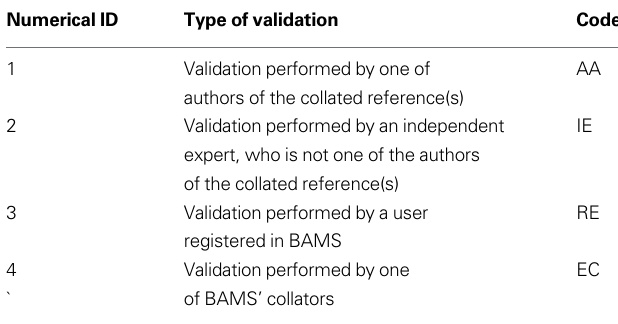
Table 4 | Human agents types and associated codes implemented in BAMS as part of the validation schema. See Text for details.